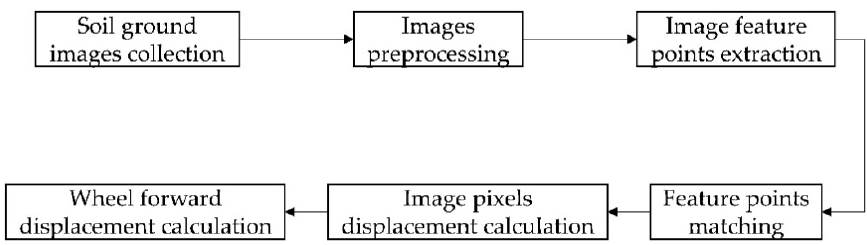
Figure 1. The calculation process of the wheel forward displacement.